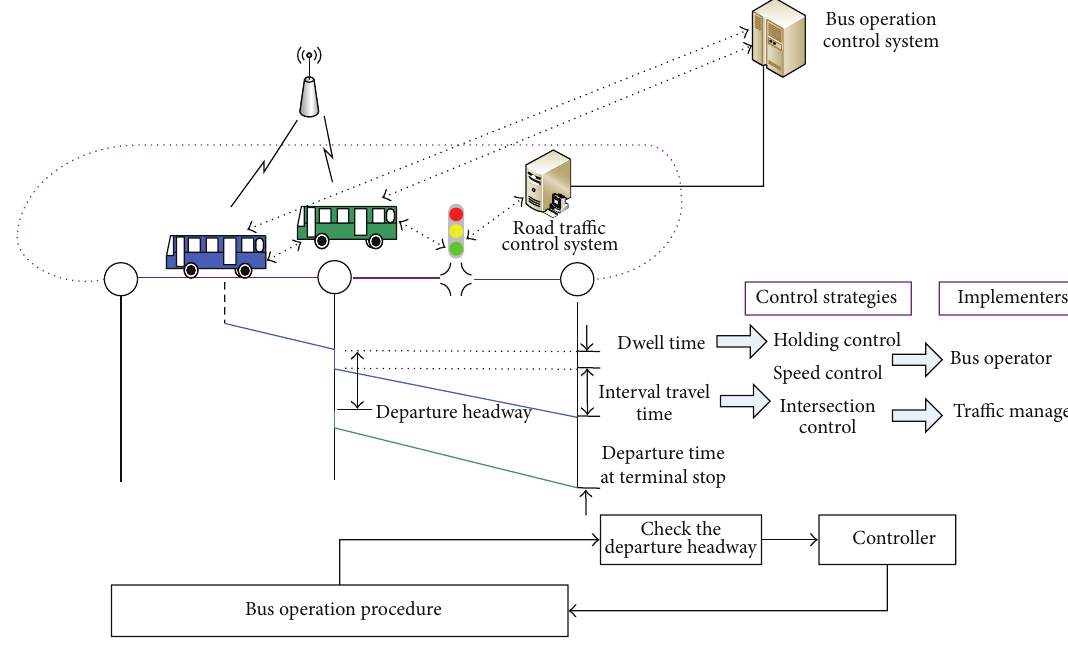
Figure 2: Control system architecture.